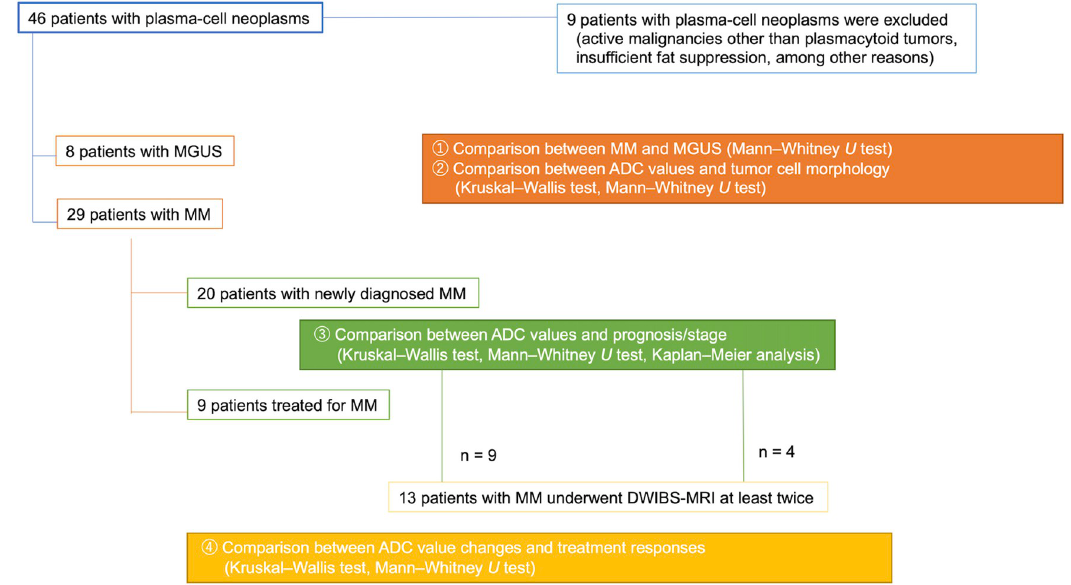
Fig 1. Study flowchart. The object of each study and statistical analysis method are shown. ADC, apparent diffusion coefficient; DWIBS-MRI, diffusion-weighted imaging with body signal suppression magnetic resonance; MGUS, monoclonal gammopathy of undetermined significance; MM, multiple